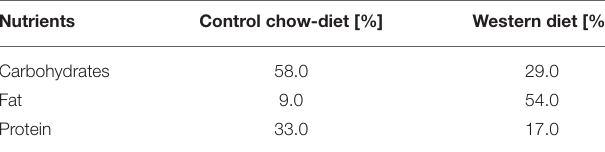
TABLE 3 | Percentage composition of energy derived from particular diet